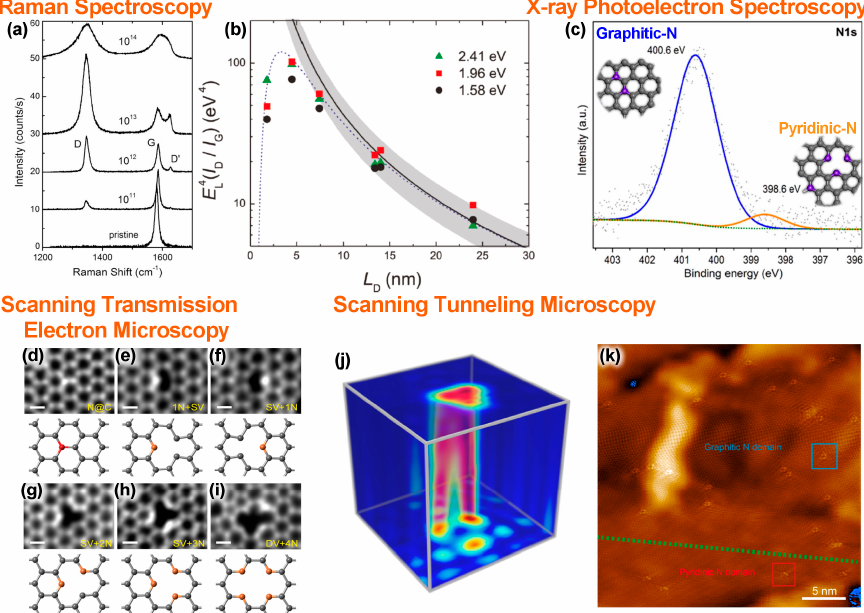
Figure 3. ( a – c ) Characterization of nitrogen dopant concentration and ( d – k ) dopant configuration.